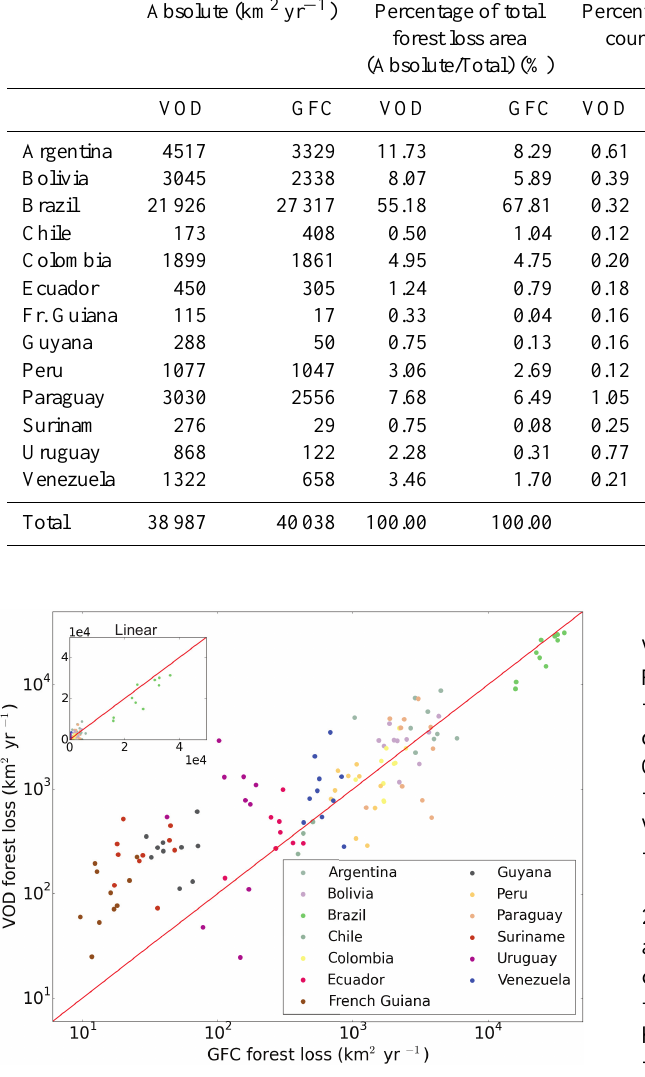
largest relative forest loss is Paraguay for both VOD (1.05 %) and GFC (0.98 %). In Fig. 7 we show these derived annual forest loss data from VOD for the full time period, along with GFC for 2001 through 2010. Obviously the average for- est loss area for the overlapping period agrees between both data sets because our approach was tuned to match GFC, but the spatial and temporal variability can be different, poten- tially yielding new insights.